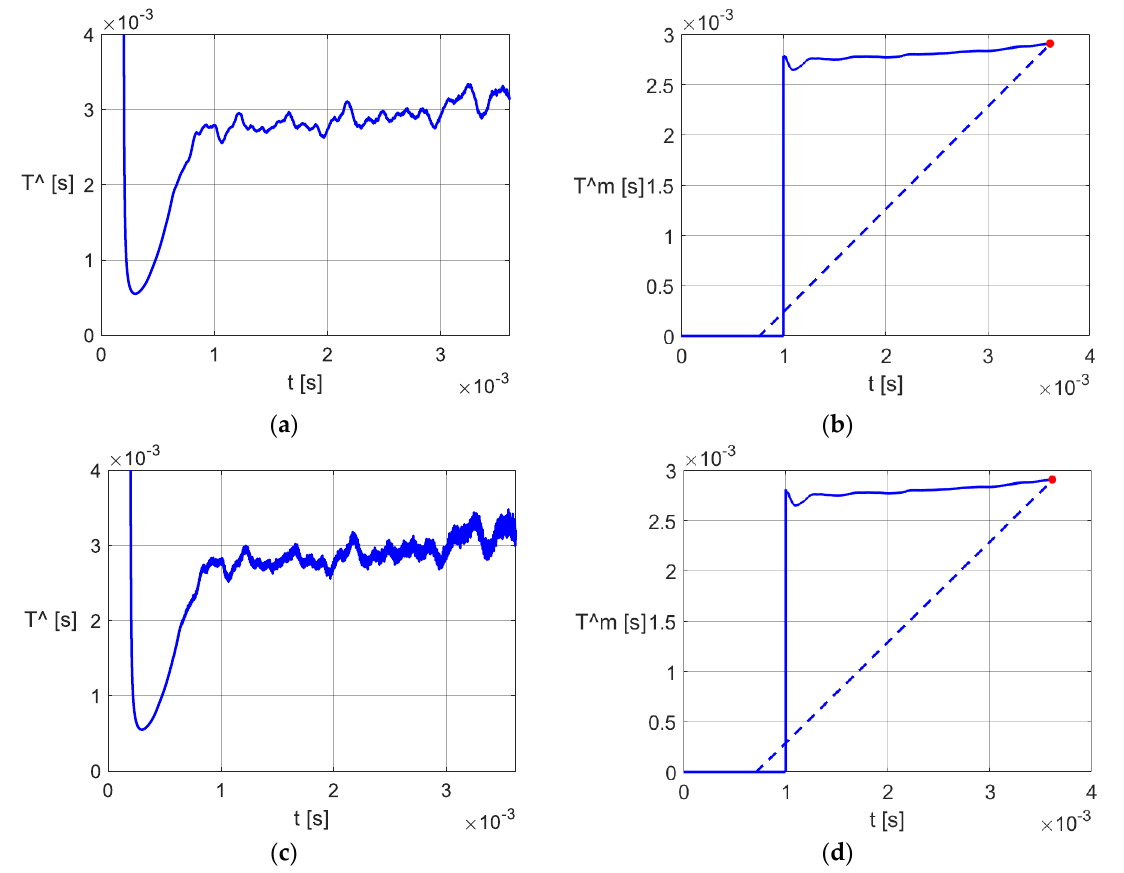
Figure 14. Results obtained with the discrete-time PO for the two-stage discharge of the 100 µF capacitor. Recording resolution: 50 ns. ( a ) The first stage of discharge; ( b ) the second stage of discharge.